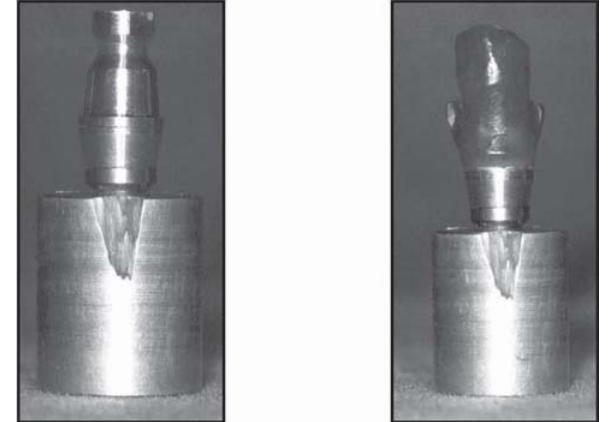
FIGURE 3- Premachined cylinder secured to the implant (left). Wax-up for definitive prosthesis (right)